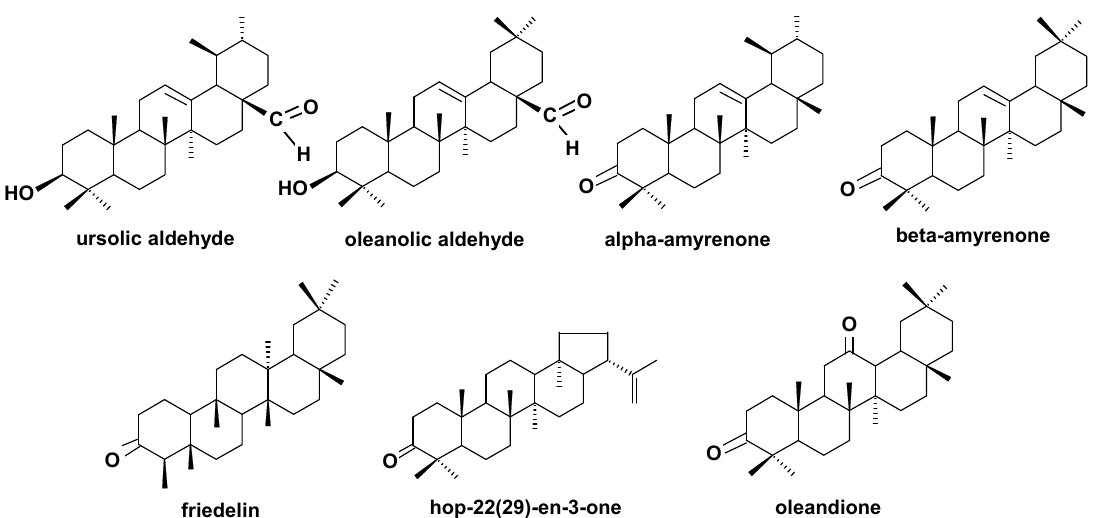
Figure 5. The structures of pentacyclic neutral triterpenoids (aldehydes and ketones).